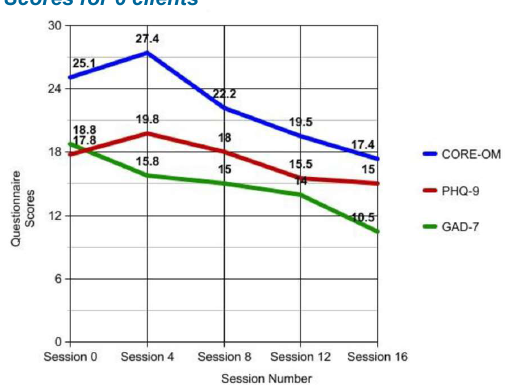
Figure 1: Mean CORE-OM, PHQ-9 and GAD-7 Scores for 6